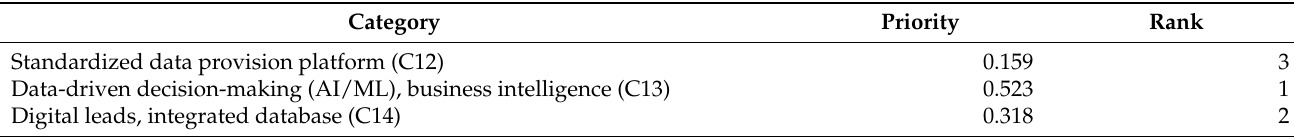
Table 15. Consolidated priorities for D4